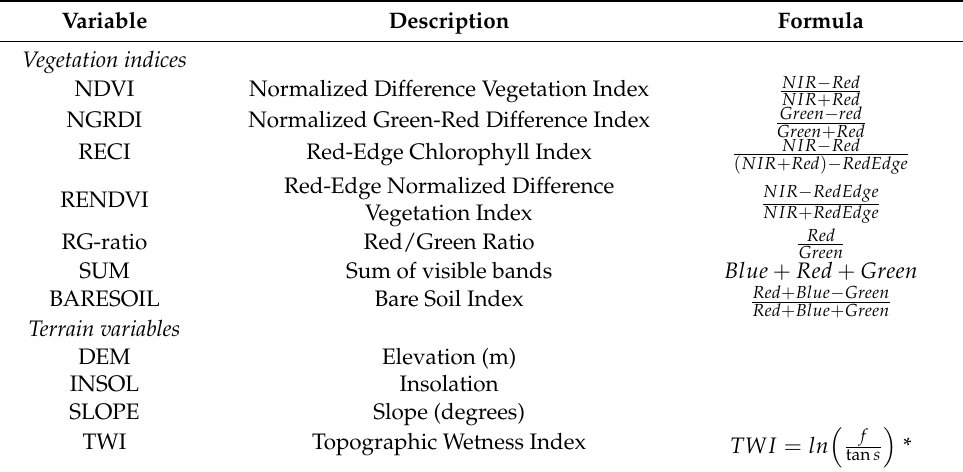
Table 1. Vegetation indices from RapidEye imagery and terrain metrics used for feature extraction as inputs to the random forest model for the Image-based classification. Variable Description Formula Vegetation